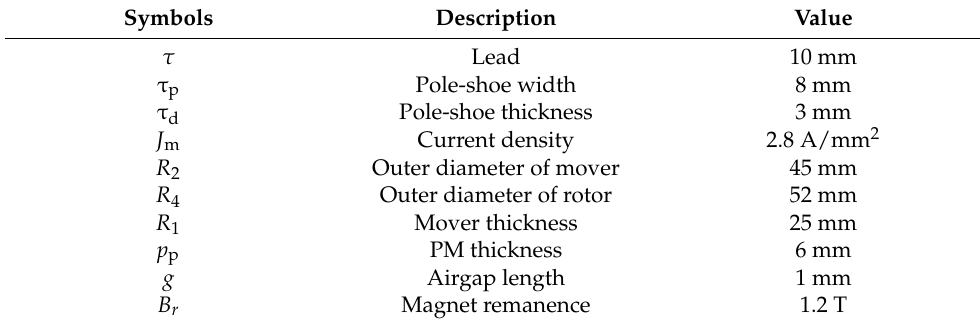
Table 1. Specification of the verified model. Symbols